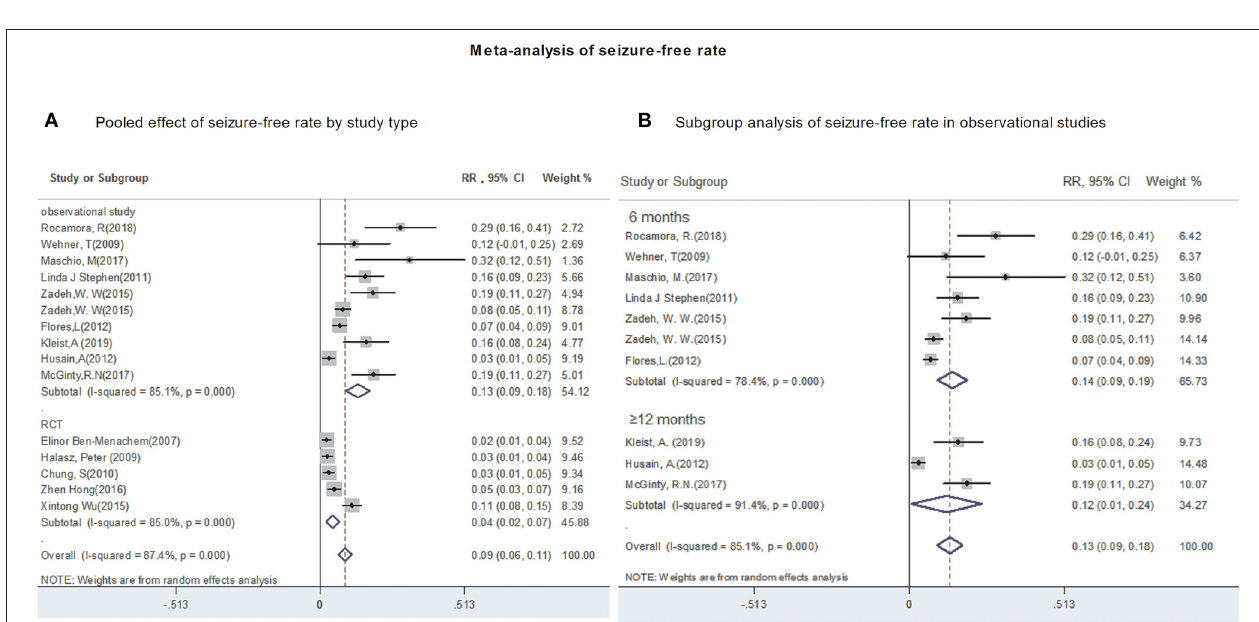
FIGURE 3 | Meta-analysis of seizure-free rate. (A) Poole effect of seizure-free rate by study type. (B) Subgroup analysis of seizure-free rate in observational studies.